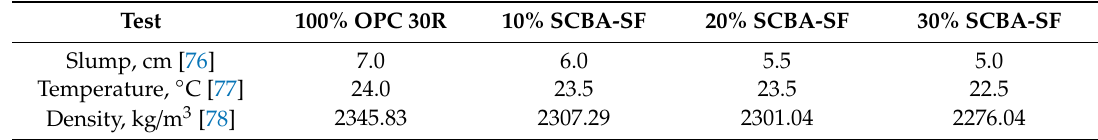
Table 3. Physical properties of individual